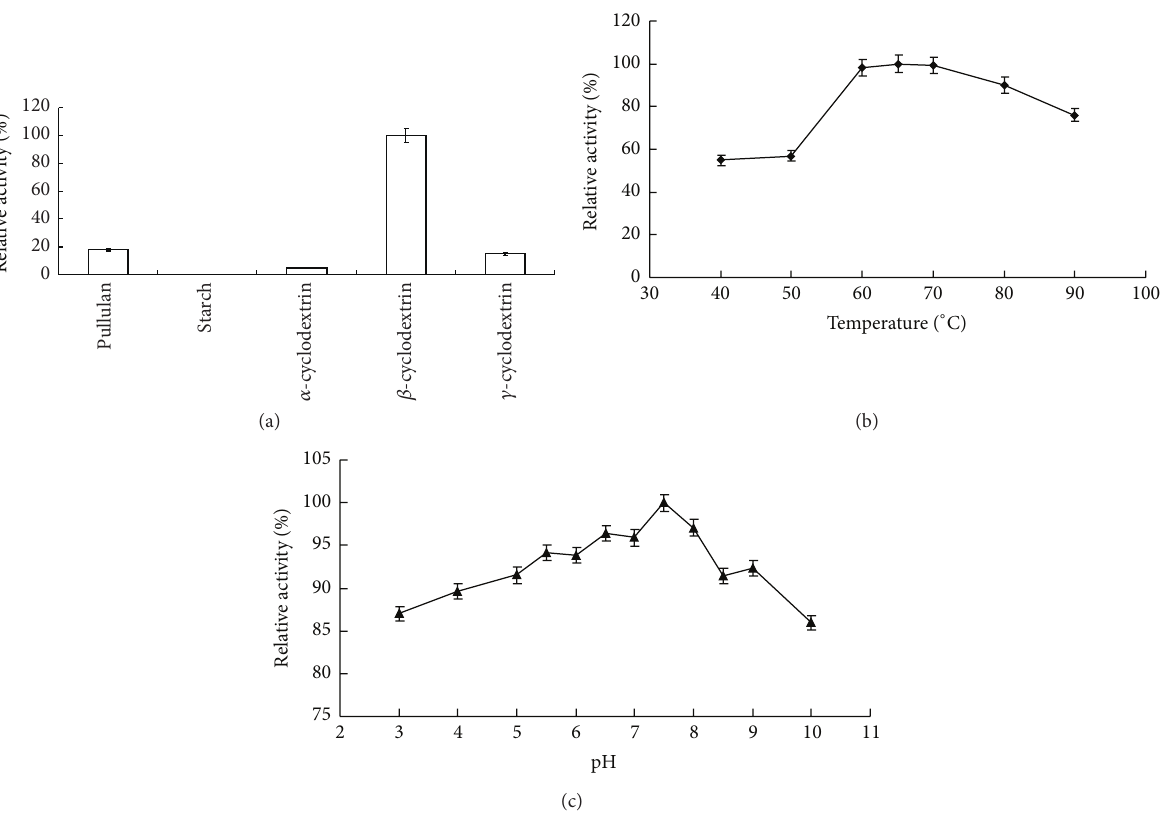
Figure 3: Influence of temperature on the activity and influence of pH on the activity and stability of CDase-Tk. (a) Hydrolytic activity of CDase-Tk to pullulan, starch, and cyclodextrin. (b) Optimal temperature of CDase-Tk. (c) Optimal pH of CDase-Tk. Different buffers were used for the different pH solutions used in this assay. Sodium acetate was used for pHs 3.0, 4.0, and 5.0; MES buffer was used for pHs 5.0 to 7.5; HEPES buffer was used for pHs 8 and 8.5; glycine buffer was used for pHs 9.0 and 10.0. The concentrations of the buffers were 50 mM.